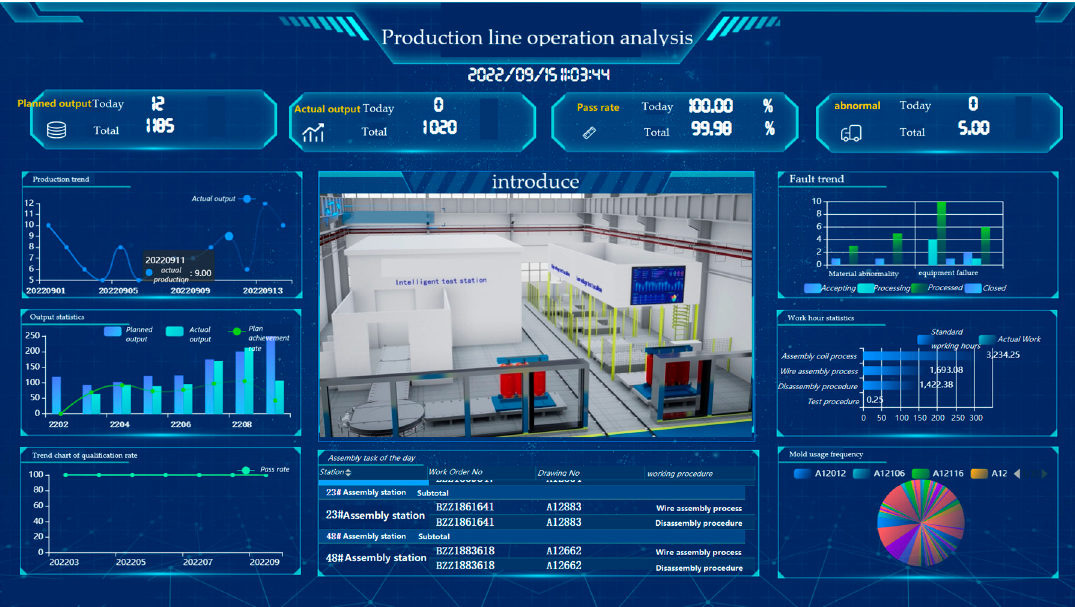
Figure 8. Production line operation analysis screen.